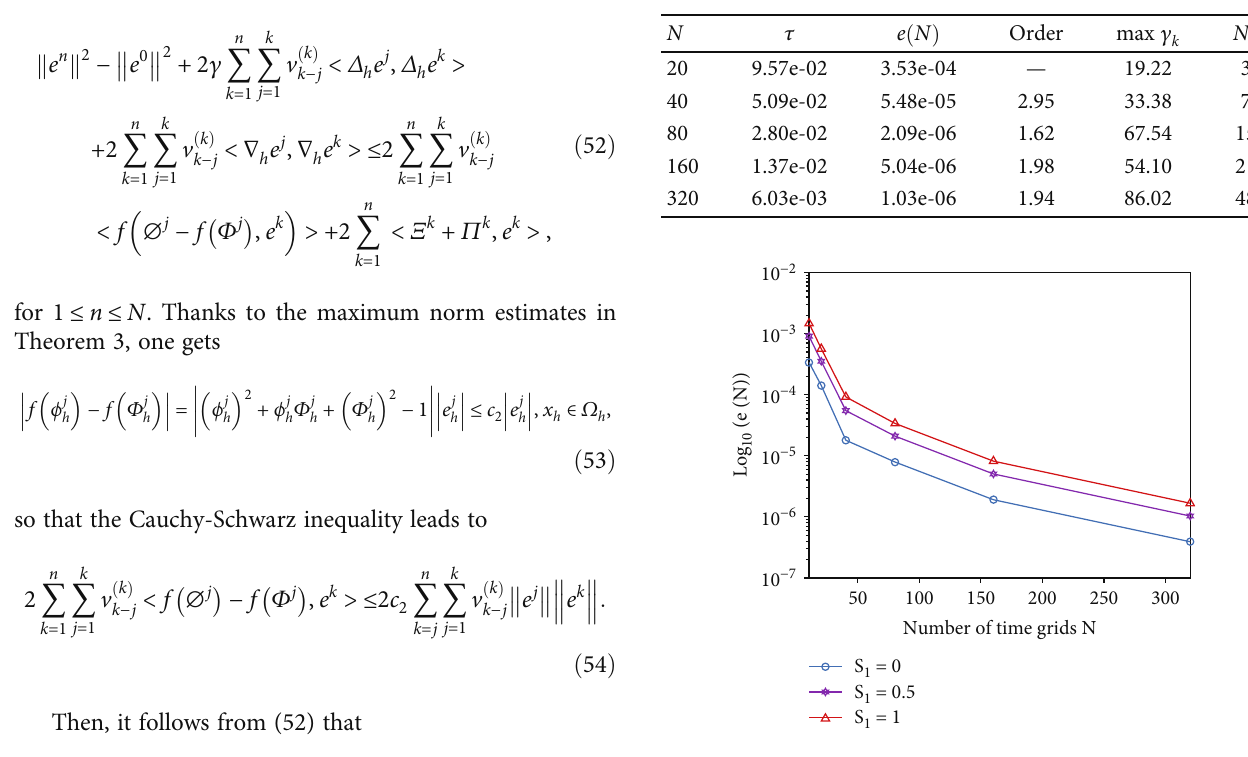
Figure 1: The semilog plot of numerical error e(N) of stabilized BDF2 scheme (6) with di ff erent stabilization parameters S